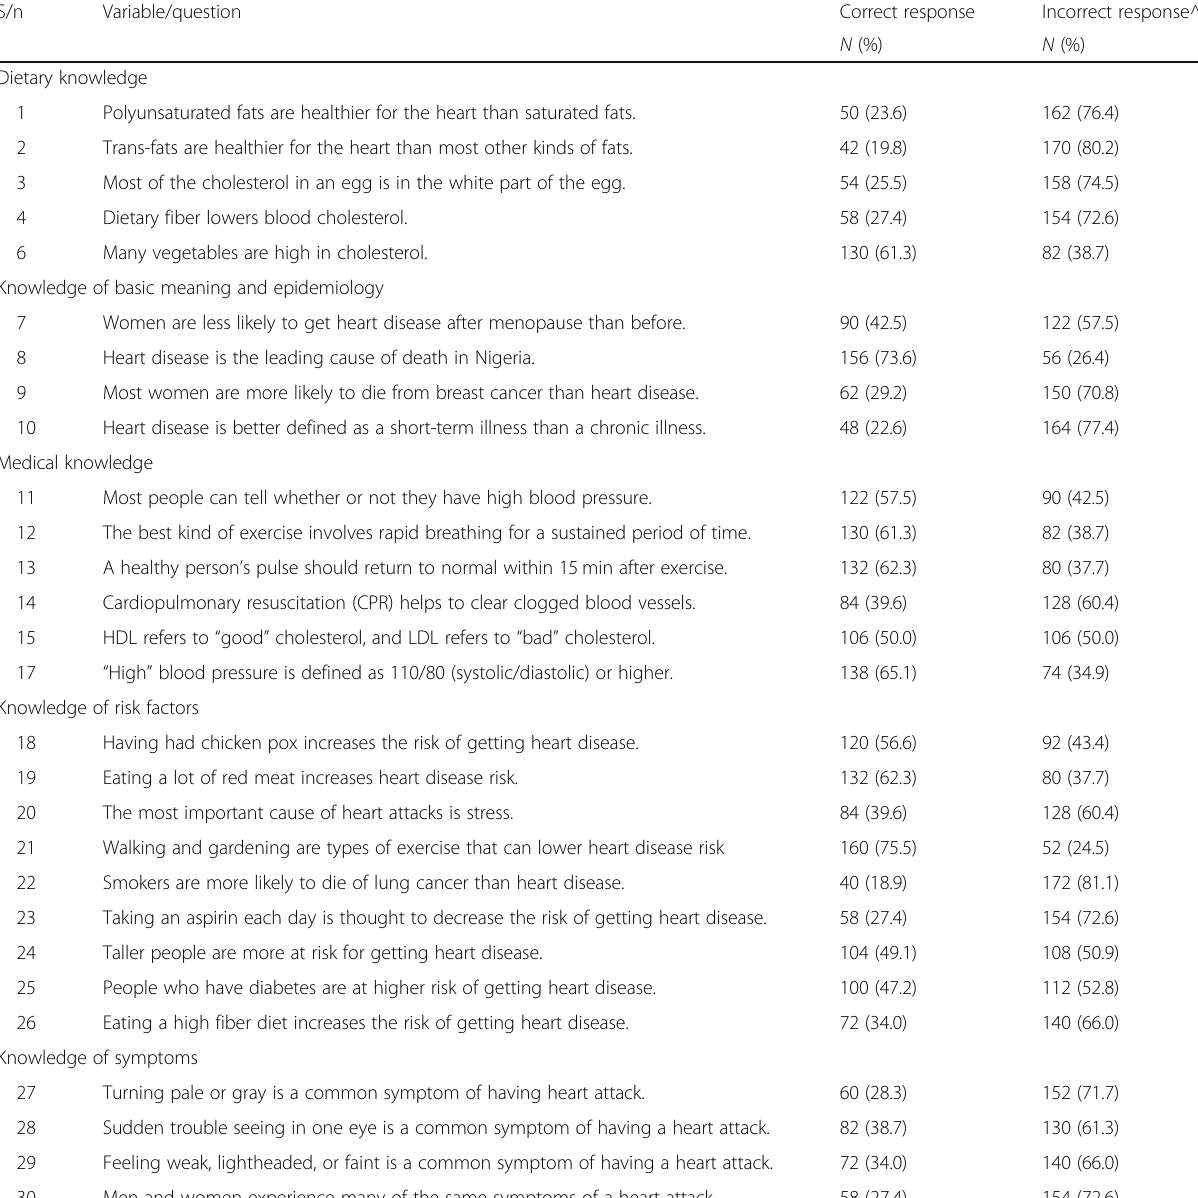
Table 3 Distribution of knowledge of cardiovascular disease ( N = 212) Variable/question Correct response Incorrect